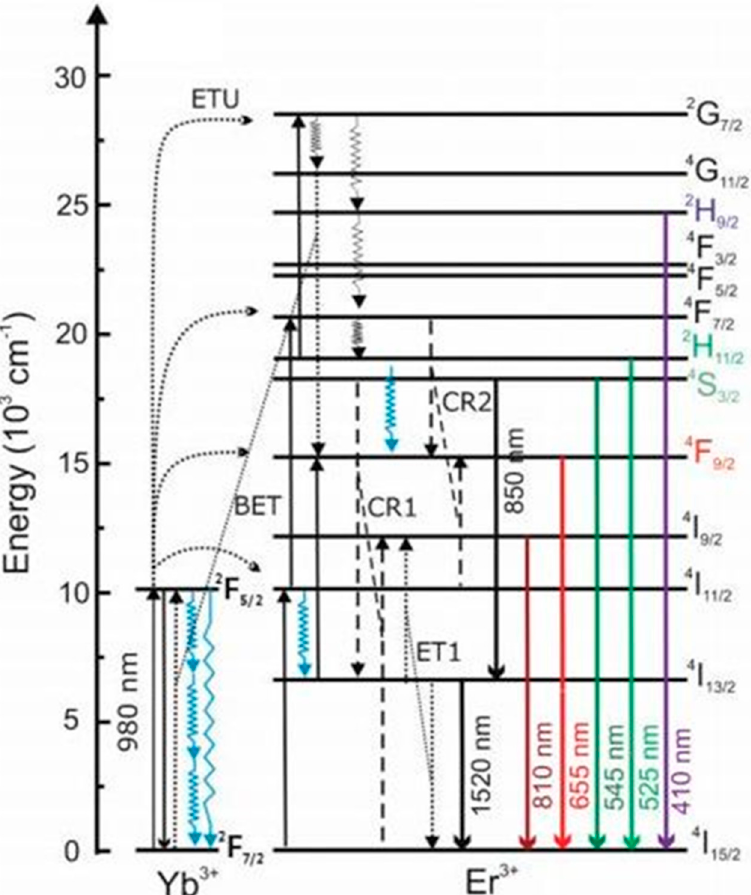
Figure 5. Energy scheme of Yb 3+ , Er 3+ co-doped NaYF4; ET: energy transfer, ETU: energy transfer upconversion, CR: cross relaxation, and BET: back energy transfer. The Yb 3+ ground state absorption (GSA) processes do not generally occur at the same Yb 3+ ion or at neighboring Yb 3+ ions, yet the absorbed energy migrates from the absorption site to Yb 3+ ions adjacent to Er 3+ upconverting centers. Thus, the Yb 3+ energy level diagram represents Yb 3+ in the NaYF 4 lattice, whereas the Er 3+ energy level diagram represents a single Er 3+ ion. Right, top panels: P-dependence of the photon upconversion luminescence of DSPE-stabilized UCNPs in water and D 2 O. Exemplarily shown are spectrally corrected emission spectra of DSPE-capped UCNPs in water (black lines) and D 2 O (red lines) at low P of ca. 16 W cm − 2 [63].